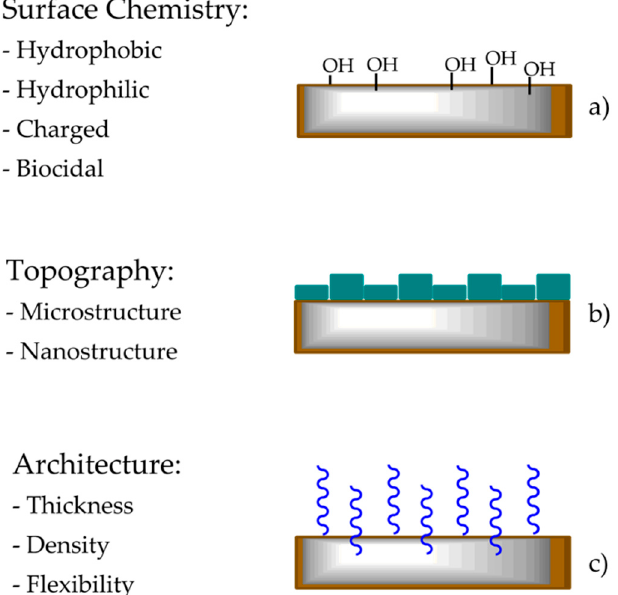
Figure 2. The strategies to provide a surface with antifouling features are ( a ) alteration of surface chemistry, ( b ) surface topography, and ( c ) the coating design. Surface chemistry determines the way foulants interact with the surface, which should be hydrophilic, hydrogen bond-forming, and electrically neutral [11]. The antifoul- ing ability of hydrophilic and zwitterionic surfaces is related to the high hydration and surface energy because the tightly bound water layer constitutes a physical barrier, inhib- iting adsorption [12]. On the other hand, a hydrophobic surface with lower surface energy